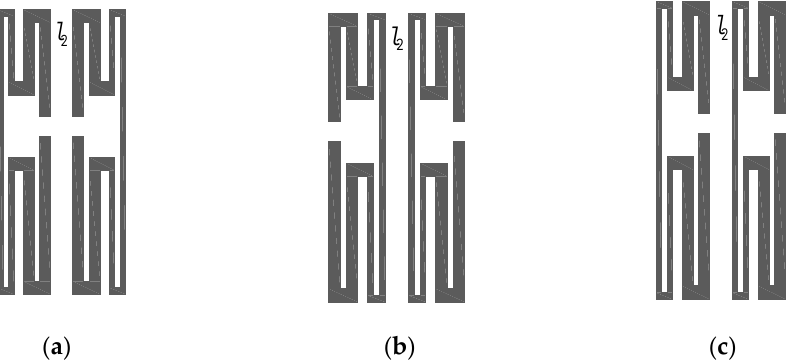
Figure 6. Coupling structure between resonators of type II. ( a ) Face to face; ( b ) back to back; ( c ) in order.